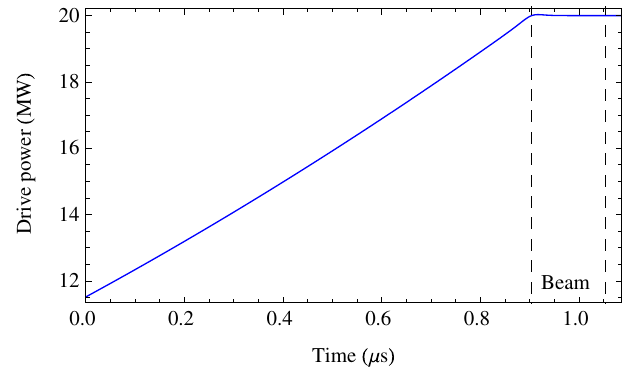
FIG. 4. The rf drive of the linac with beam that levels the energy gain as a function of time as shown in Fig. 3. Injected current is 100 mA and beam is on crest. The dashed lines delimit beam injection.